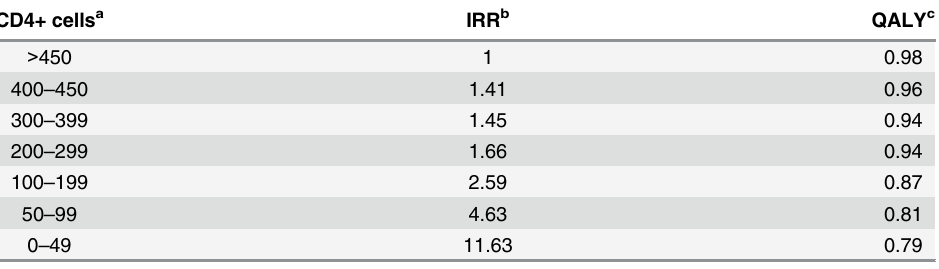
Table 1. CD4+ counts and changes in mortality and health-related quality of life values used for the base case analysis. CD4+ cells